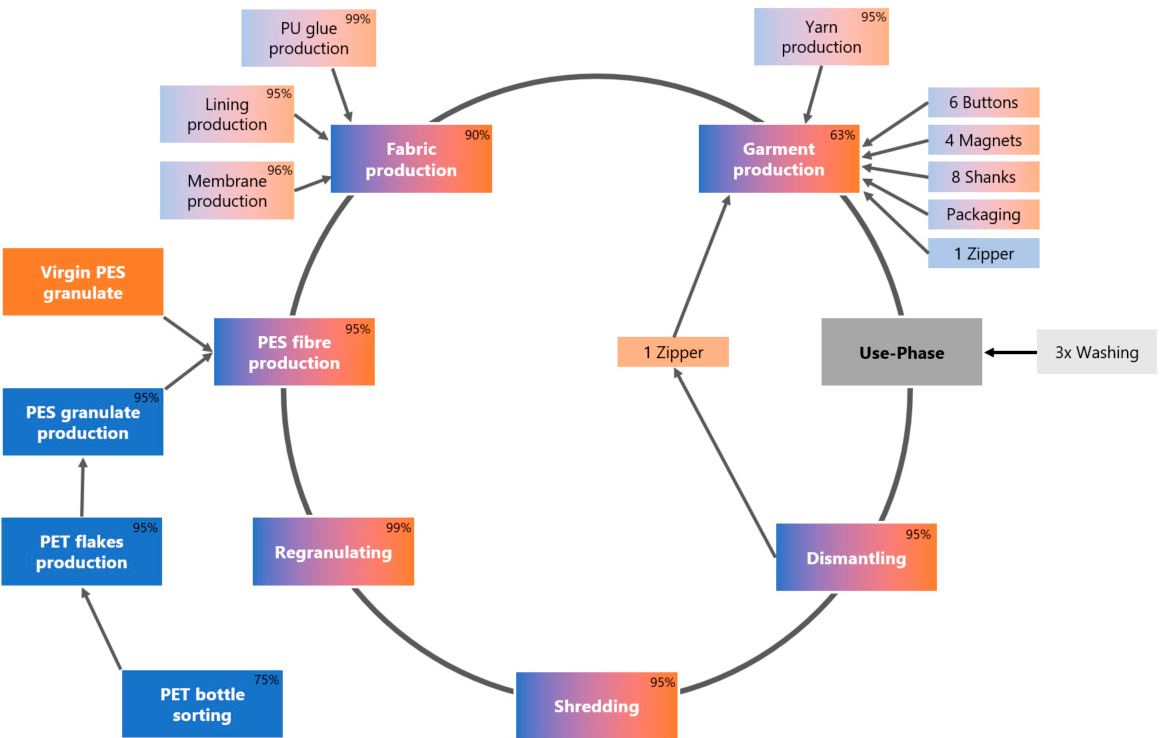
Figure 2. Multiple wear2wear TM product systems interlinked by recycling and reusing activities (in blue the first loop—in orange all subsequent loops). The raw material (polyethylene-terephthalate (PET) bottles or polyester (PES) granulate) are transformed into fibers, which are manufactured into a fabric by adding the lining, membrane, and polyurethane glue. Adding the auxiliary products, the fabric is assembled into a ready-to-wear jacket (i.e., the garment). During the use phase, the retailer washes it in an industrial plant as a service. In the entire lifetime of the jacket (four years), it is washed three times. After the use phase, the zipper is dismantled for reuse. The remaining fabric is shredded and the PES is regranulated by a polymer melting process to be available for the next product loop. The material losses occurring in every manufacturing process (displayed by the process efficiencies given in percentage) are replaced by virgin PES, indicated by the orange box.